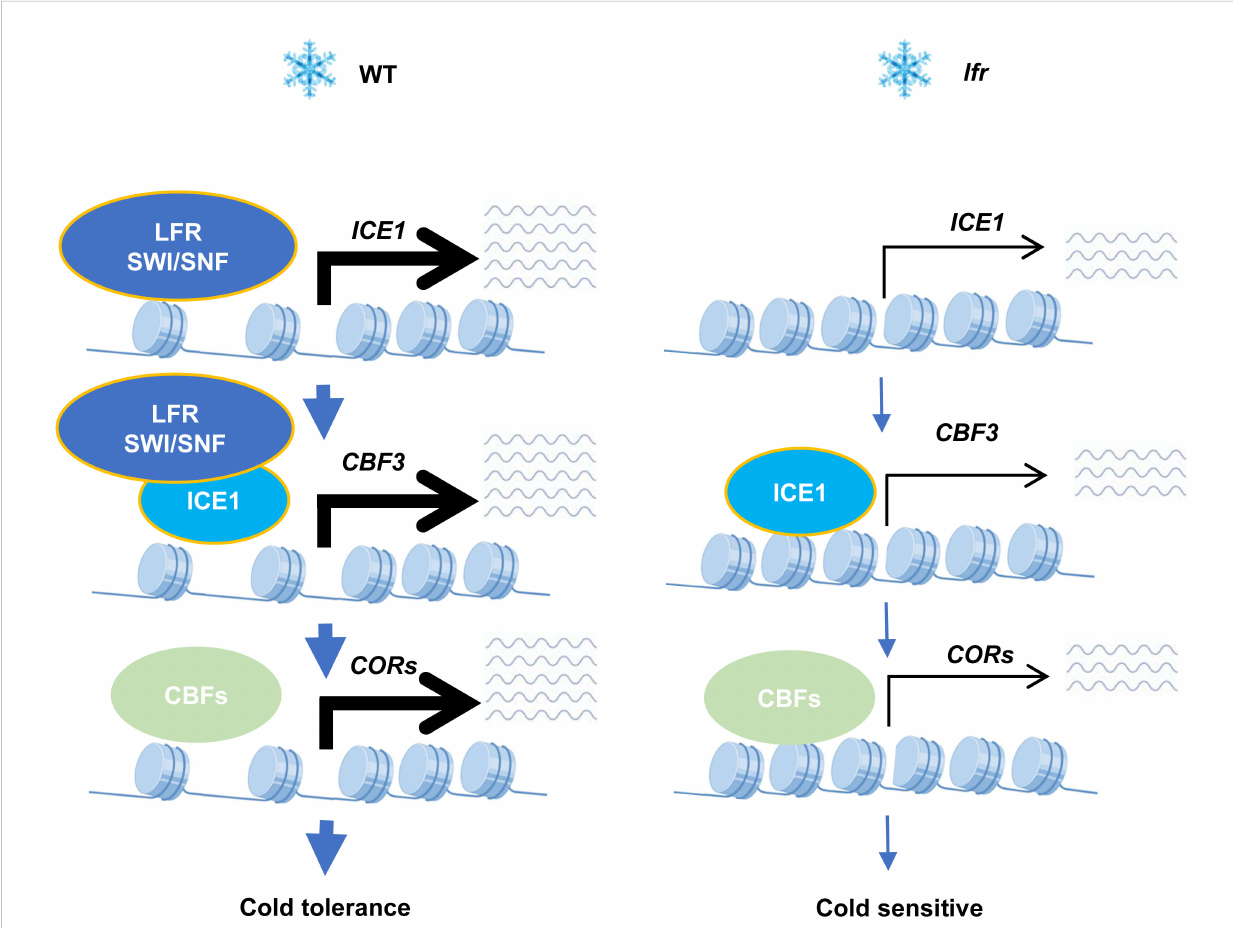
FIGURE 7 A working model of the function of the SWI/SNF subunit LFR in cold acclimation. Under low-temperature conditions, the SWI/SNF complex component LFR promotes plant survival by acting as a positive regulator of the ICE1 – CBF – COR cascade through its physical interaction with ICE1. The depletion of LFR results in the downregulation of ICE1 – CBF – COR cascade genes and cold-sensitive